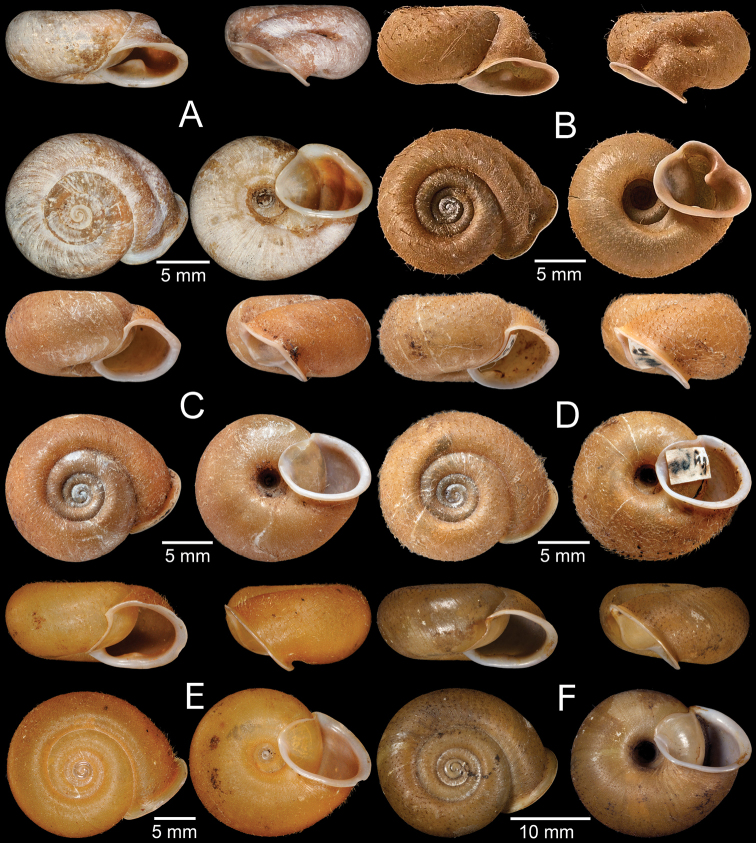
ATrichelix
hiraseana, lectotype ANSP 89999 BTrichelix
horrida, lectotype NHMUK 20200202/1 CTrichelix
eucharista, syntype NHMUK 19991540 of Chloritis
malangensisDTrichelix
oshimana, syntype NHMUK 1922.8.29.83 E, FTrichelix
tokunoensisE lectotype ANSP 87680 and F paralectotype ANSP 90048.